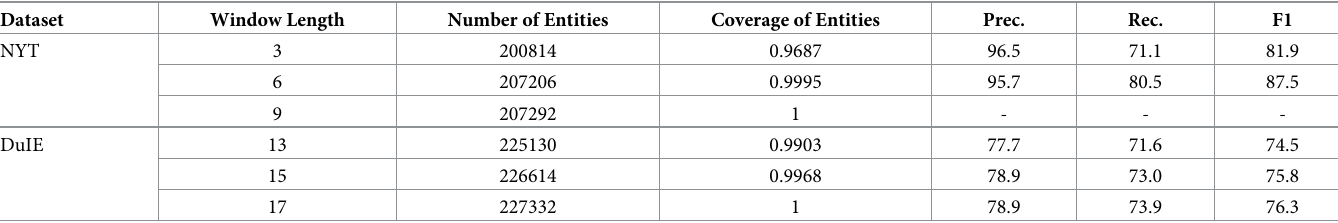
Table 5. Comparison experiment results of mapping strategy. Dataset Window Length